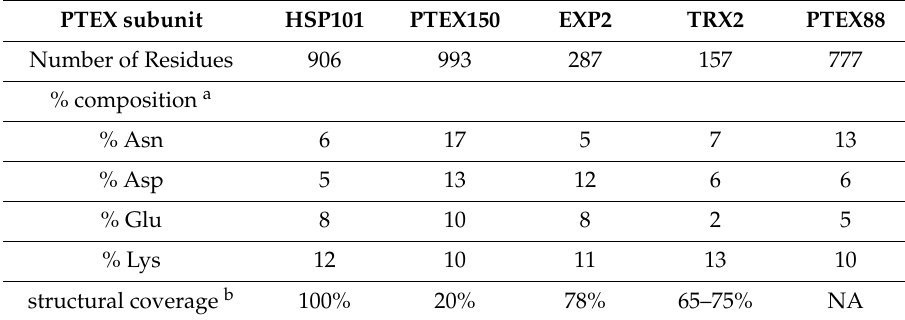
Table 2. Amino acid usage in PTEX